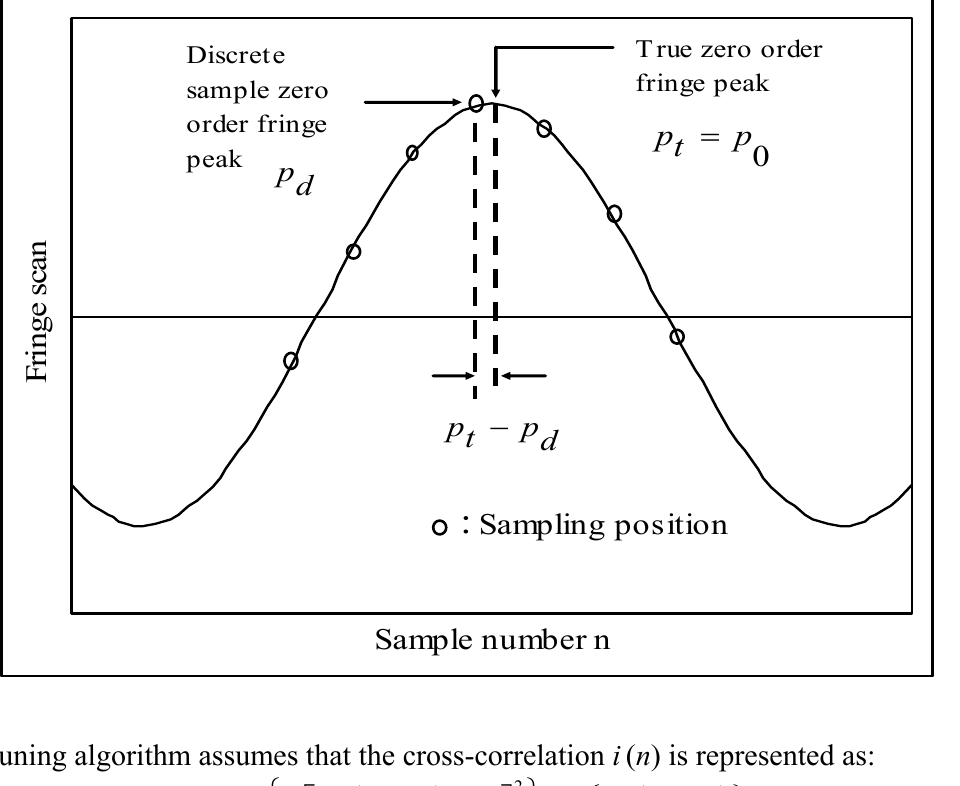
Figure 8 . Illustration for true zero order fringe peak and discrete sample zero order fringe peak of i ( n